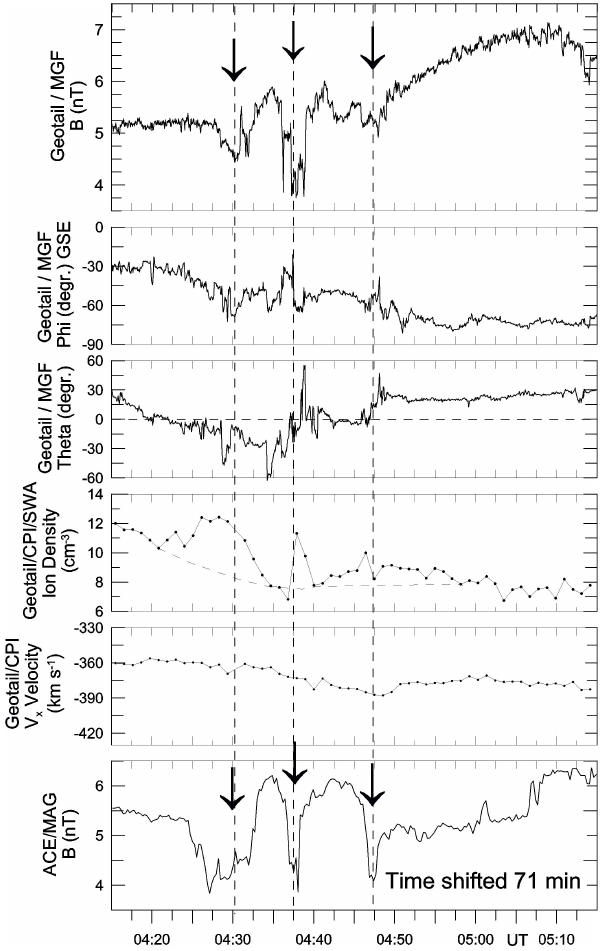
Fig. 4. Geotail/MGF vector magnetic field measurements along with the Geotail/CPI/SWA ion density and velocity. At the bot- tom panel, the ACE/MAG trace of the solar wind magnetic field magnitude is time-shifted 71min to match the Geotail